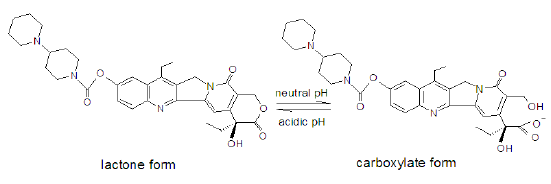
Figure 6. Evaluation of cellular uptake by emitted red fluorescence data of internalized RhB-MCM-APTES (200 μg mL -1 ), measured at 575 nm.